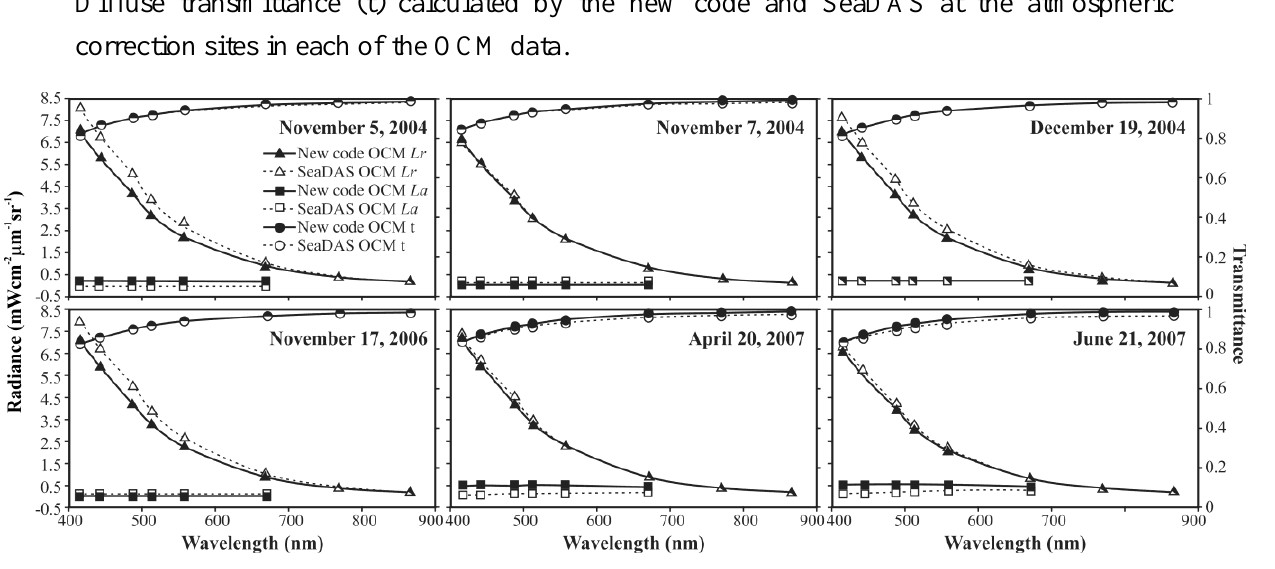
), aerosol path radiance ( L ) and r a